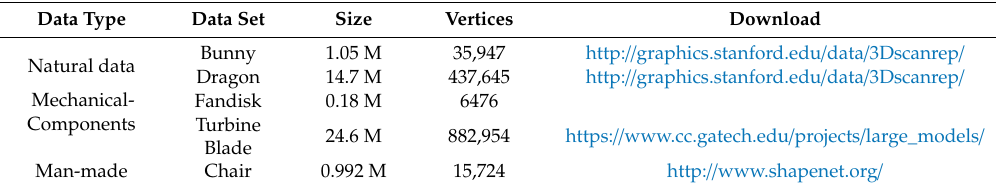
Table 2. The experimental data